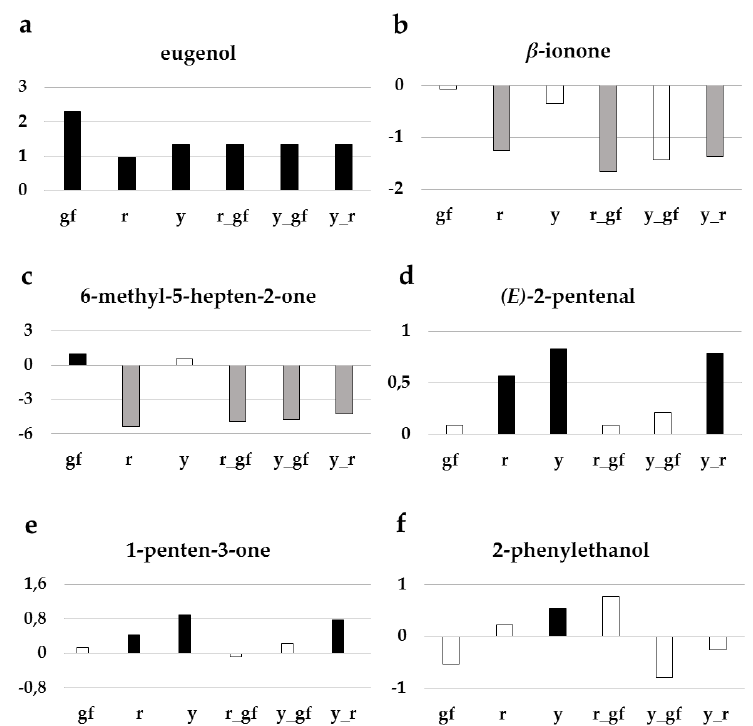
Figure 3. Relative log2 variation in selected volatiles involved in tomato flavor: ( a ) eugenol, ( b ) β -ionone, ( c ) 6-methyl-5-hepten-2-one, ( d ) (E) -2-pentenal, ( e ) 1-penten-3-one, ( f ) 2-phenylethanol in the six fruit mutant lines in San Marzano (SM) background compared with the recurrent parent. Line symbols are reported in Table 1. Bars colored in grey and black indicate means significantly lower and higher than SM for p ≤ 0.05 after Student’s t -test,